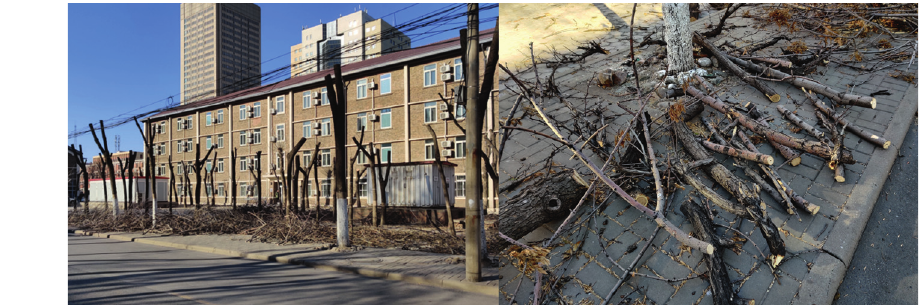
Figure 2: Material